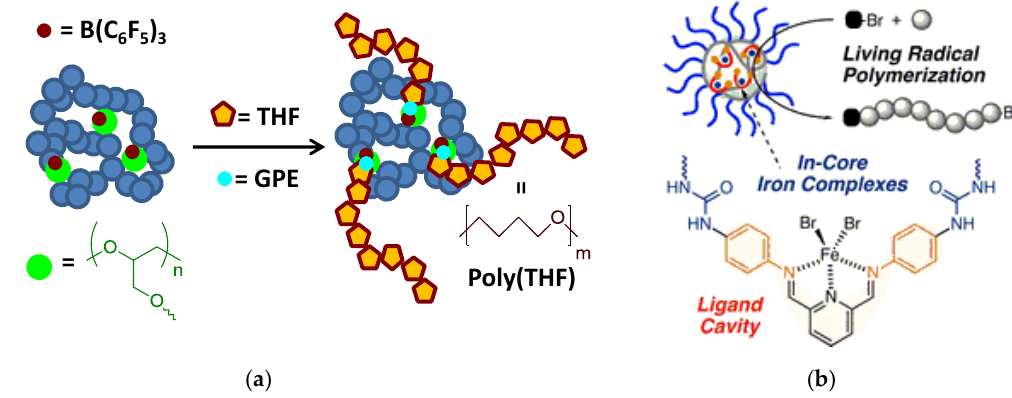
Figure 7. Schematic illustration of the use of SCNPs as bioinspired nanoreactors for the synthesis of polymers through: ( a ) ring-opening polymerization; and, ( b ) living radical polymerization (reprinted with permission from [30] and [29], Copyright American Chemical Society, 2013 and 2017, respectively).